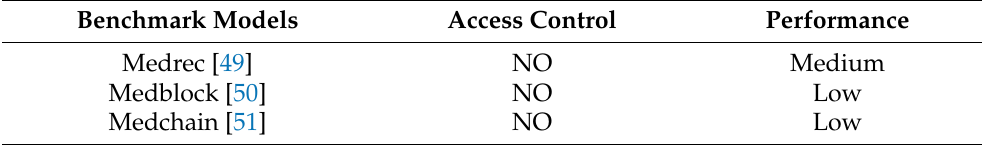
Table 1. Analysis of the benchmark models. Benchmark